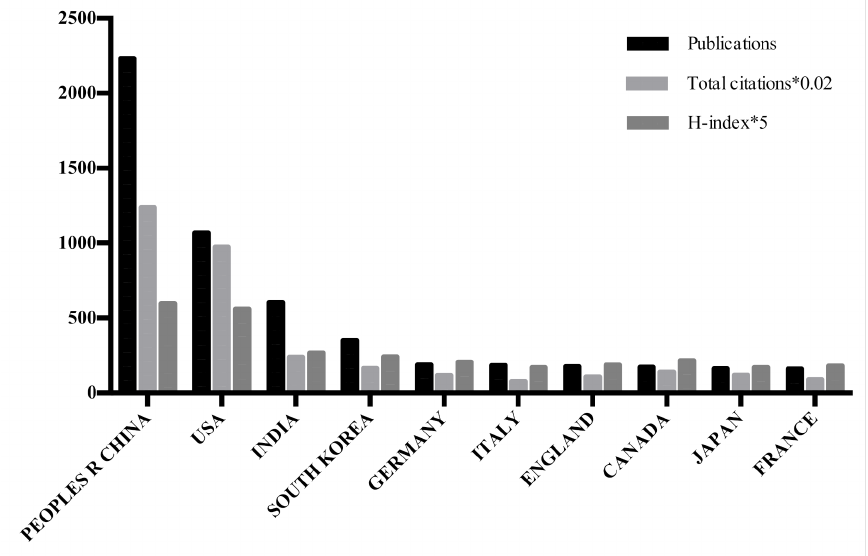
Figure 4. The number of publications, citations, and H-indexes on QDs toxicity research of the top 10